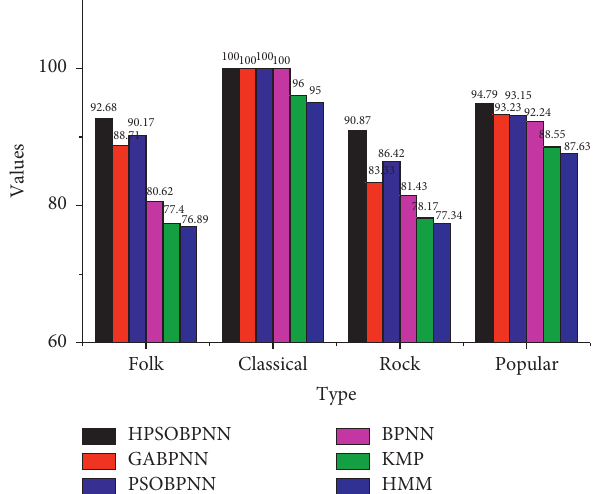
Figure 6: Classification accuracy of various models.